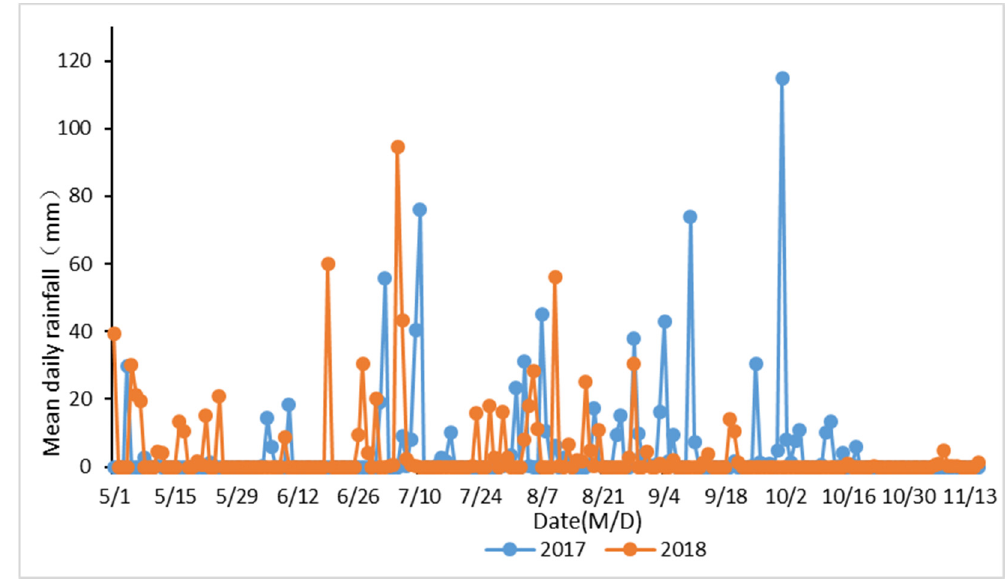
Figure 3. Mean daily rainfall in the rice growing season.